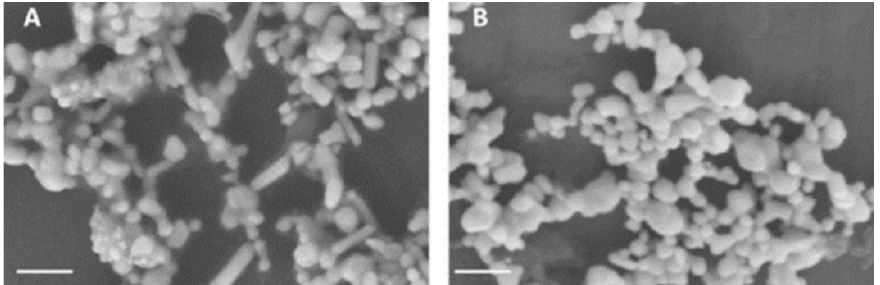
Figure A1. Optimized structure of tryptophan calculated at the B3LYP/6-311++G (d,p) level of the- ory. As defined in Figure 4, red represents Oxygen, blue is Nitrogen, grey is Carbon and white- Hydrogen atom.